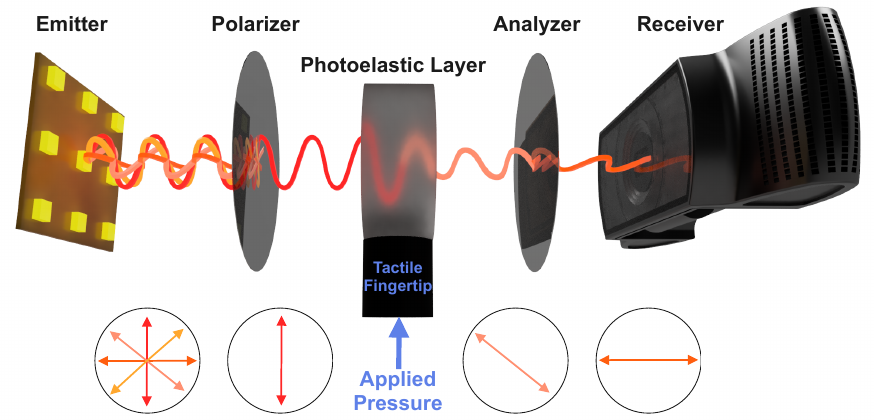
Figure 1. Illustration of the proposed photoelastic sensor for the PhotoElasticFinger. Red and orange beams represent unpolarized light from the array of LEDs. After passing through the polarizer, the polarized light enters the silicone under pressure, where the angular phase shift is changed due to stress-induced birefringence. The shifted light passes through the analyzer. The more pressure is applied, the more phase-shifted light passes through the